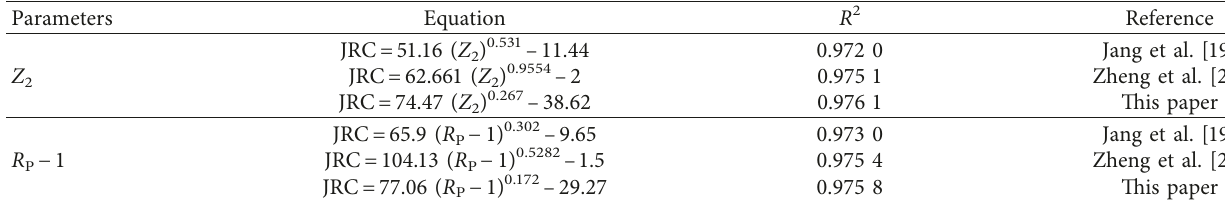
2 . (b) R P − 1. 2 and R P − 1 with